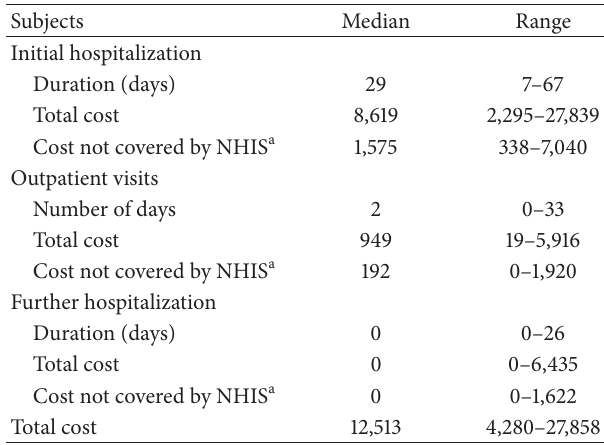
Table 2: Costs related to hospitalization and outpatient clinic visits ( 𝑛 = 14